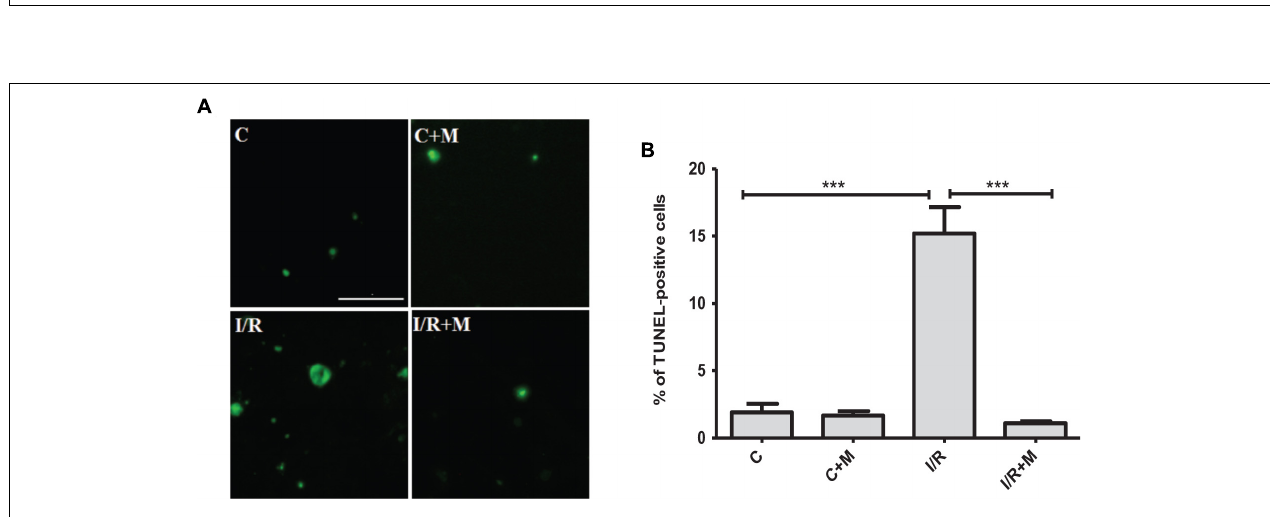
FIGURE 8 | Metformin treatment protects against cardiac apoptosis in I/R-challenged hearts. (A) . TUNEL staining of cardiac tissue from vehicle- or metformin-treated mice subjected to 30 min of cardiac ischemia and 14 days of reperfusion. Metformin treatment (5 mg/kg/day, i.p.) started at 15 min of post-reperfusion and continued for 14 days. Scale bar is 100 µ M. (B) . Quantification of apoptotic cells from (A) . Data are presented as mean ± SEM. Statistical analysis was carried out by one-way ANOVA: ∗∗∗ P < 0.001 between indicated conditions.